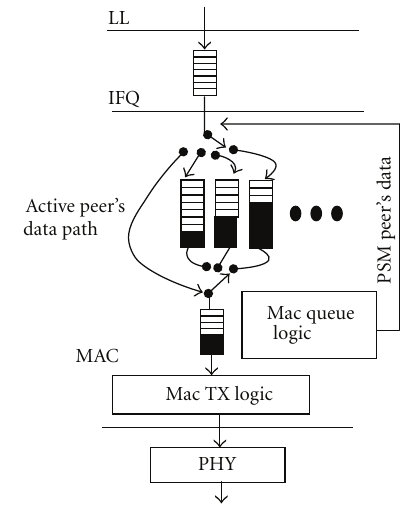
Figure 3: A simplified diagram of new queuing system where MAC maintains individual queue for each of its PSM link or